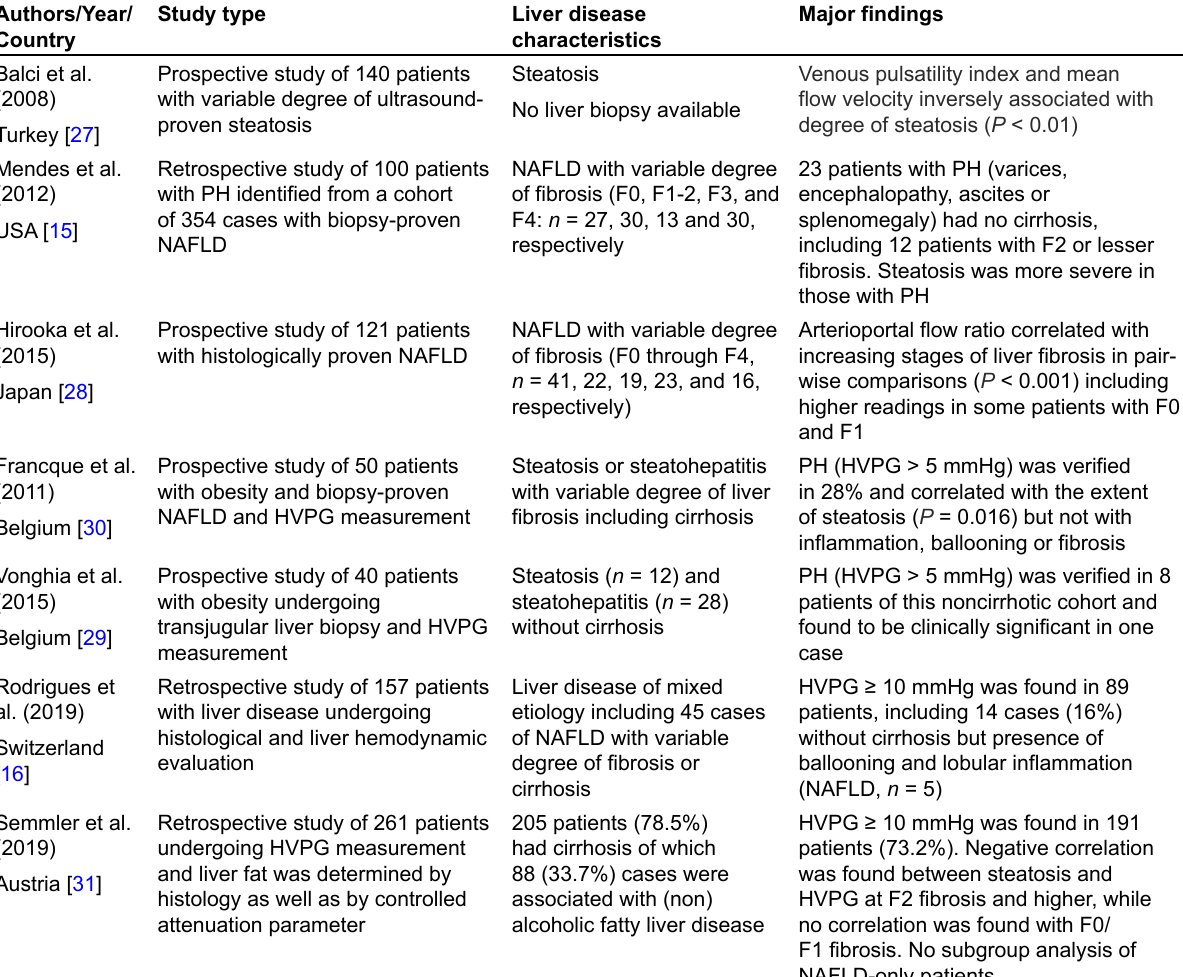
Table 2. Changes in hepatic vascular parameters reported in human